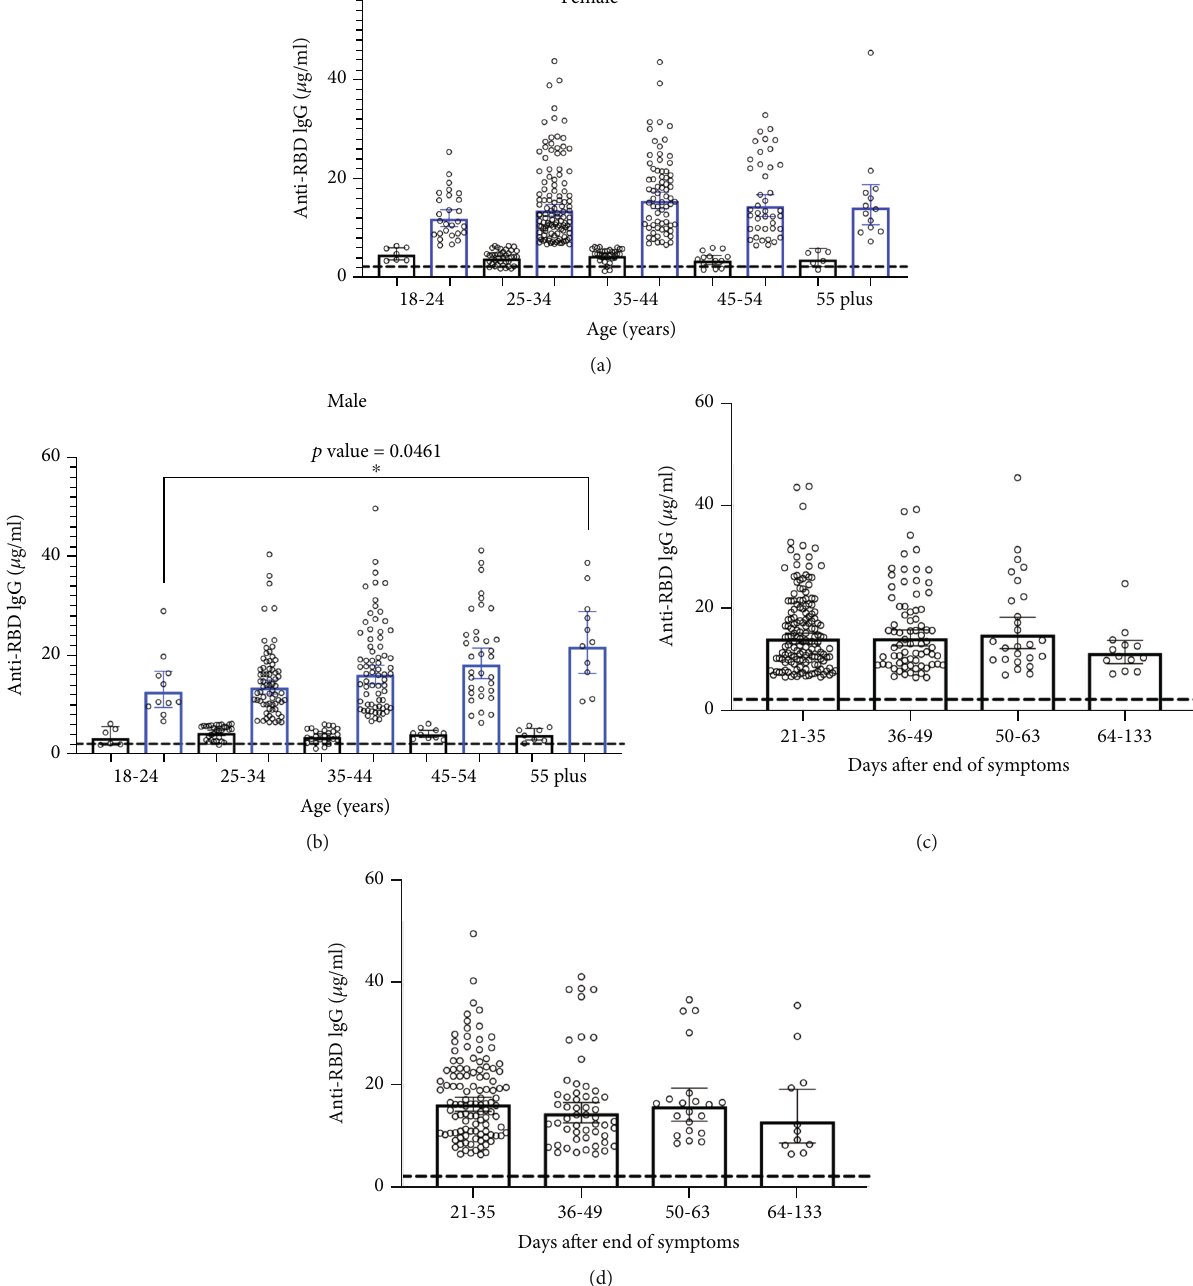
Figure 2: Strati fi ed anti-RBD IgG levels by gender, age, and days of convalescence. Measured IgG distribution for positive (blue) and negative (black) quantitative ELISA. Cases were segregated as female ( N = 361 ) (a, c) and male ( N = 278 ) (b, d) based on age and days after symptom o ff set. In all cases, the dashed line corresponds to the control